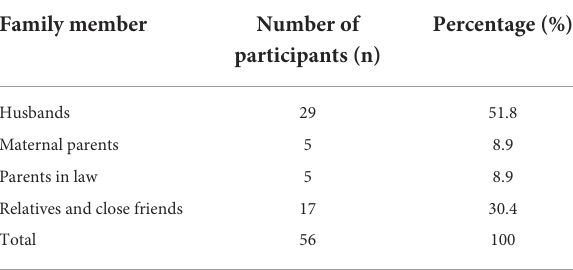
TABLE 1 The percentage of family members participating in the